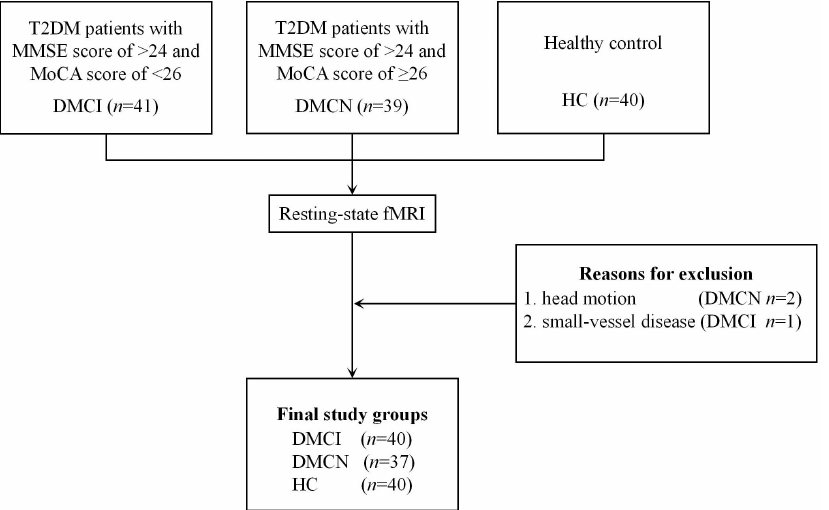
Figure 2. Flowchart of participant inclusion in the final registry and the exclusion criteria . Table 1. Demographic, clinical, and neuropsychological data of T2DM patients and healthy controls.